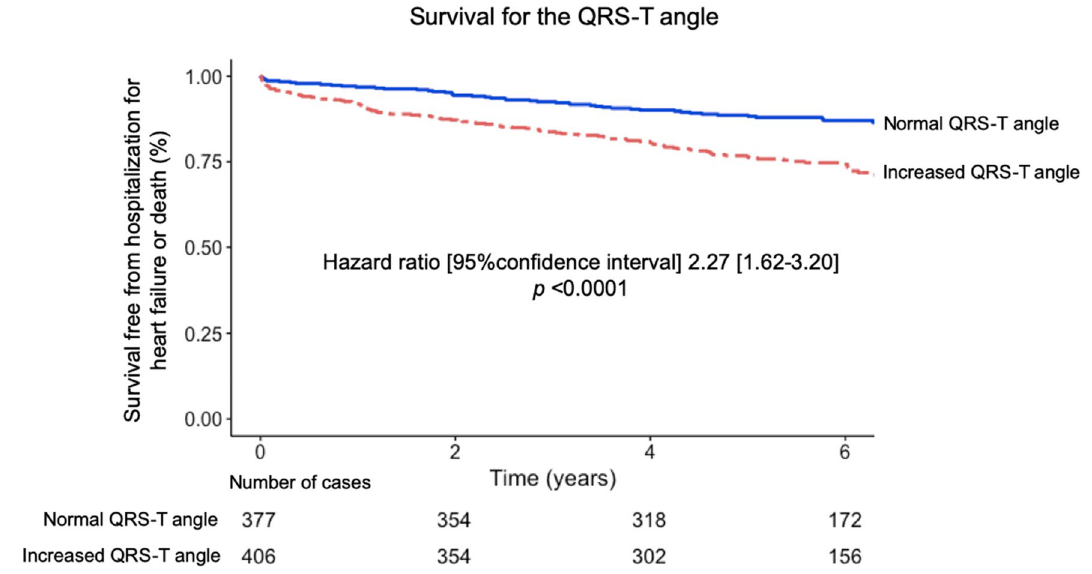
Figure 5. Outcomes for patients in the Clinical-Consecutive cohort according to the presence of a normal or increased derived spatial peaks QRS-T angle, respectively, defined as ≥ 40° for females and ≥ 55° for males. An increased QRS-T angle was associated with worse outcomes in the form of survival free from heart failure hospitalization or all-cause death with events in 155 patients over a follow-up period of 5.7 [4.4–6.6]